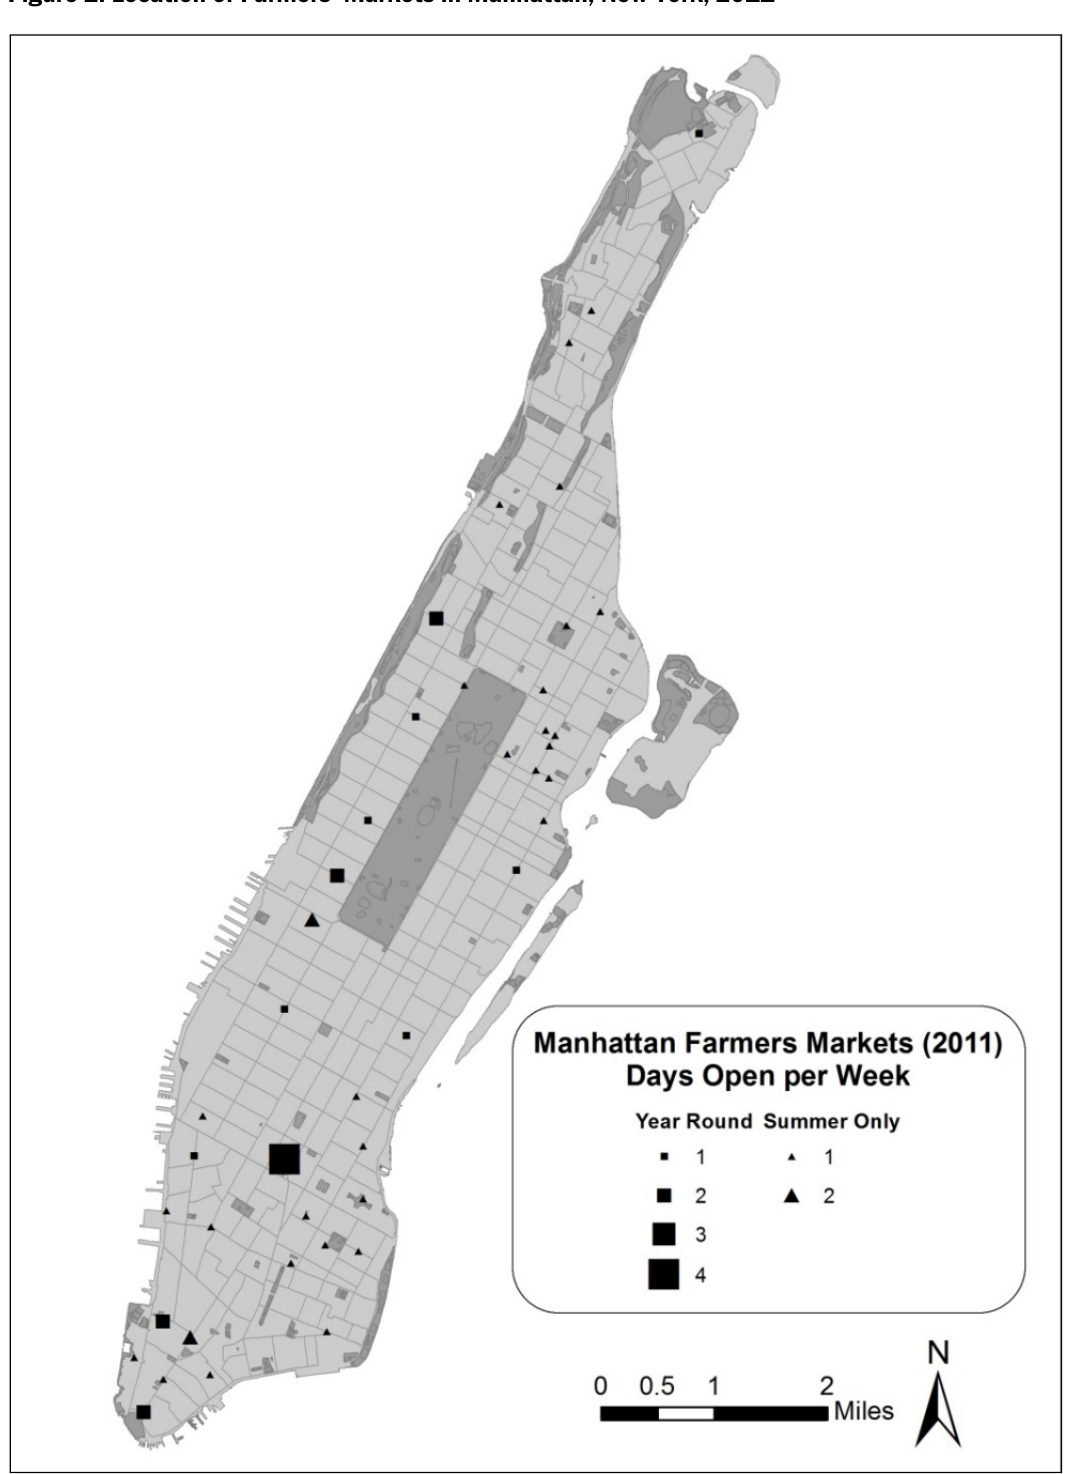
Figure 2. Location of Farmers’ Markets in Manhattan, New York,